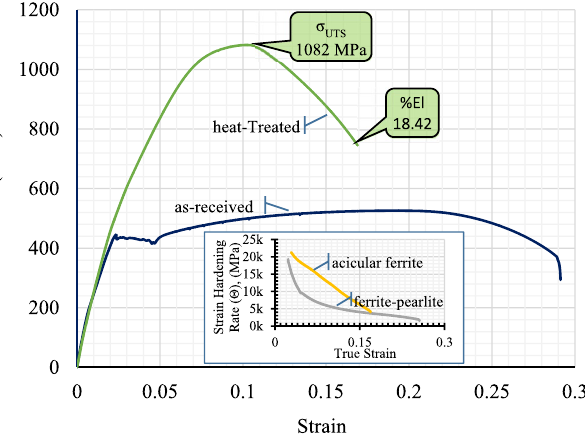
Figure 5. Tensile stress–strain behaviour (inset: strain hardening rate vs true strain) for microalloyed low carbon steel.